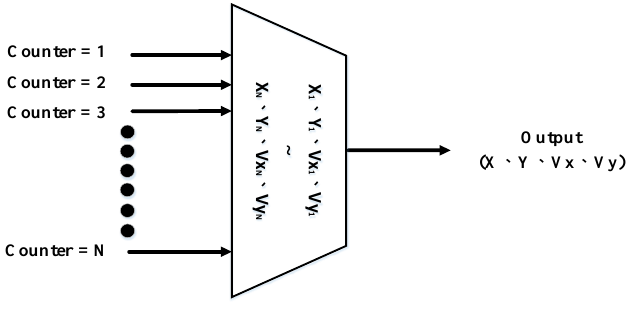
Figure 9. VLSI architecture of the input table module.